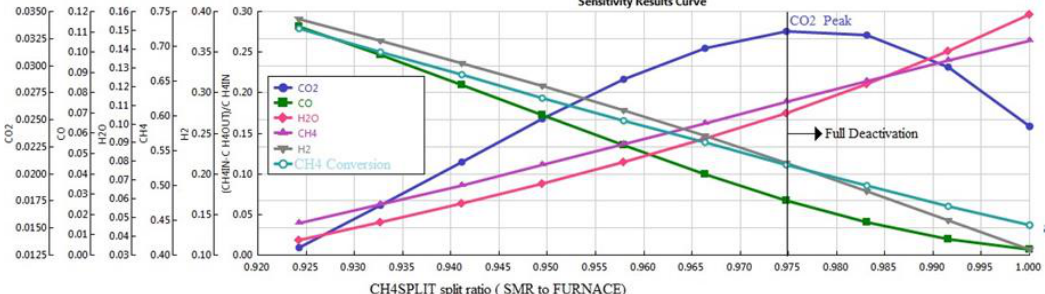
Figure 4. SMR sensitivity results (SMR molar fractions vs. CH 4 split ratio).